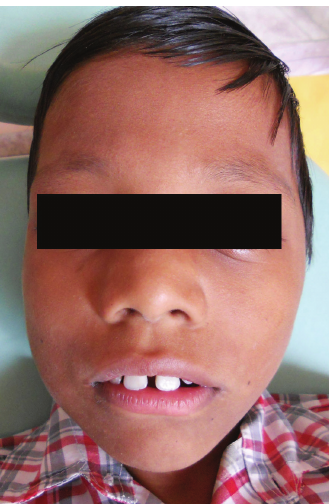
Figure 1: Showing extra oral swelling on right side of face.